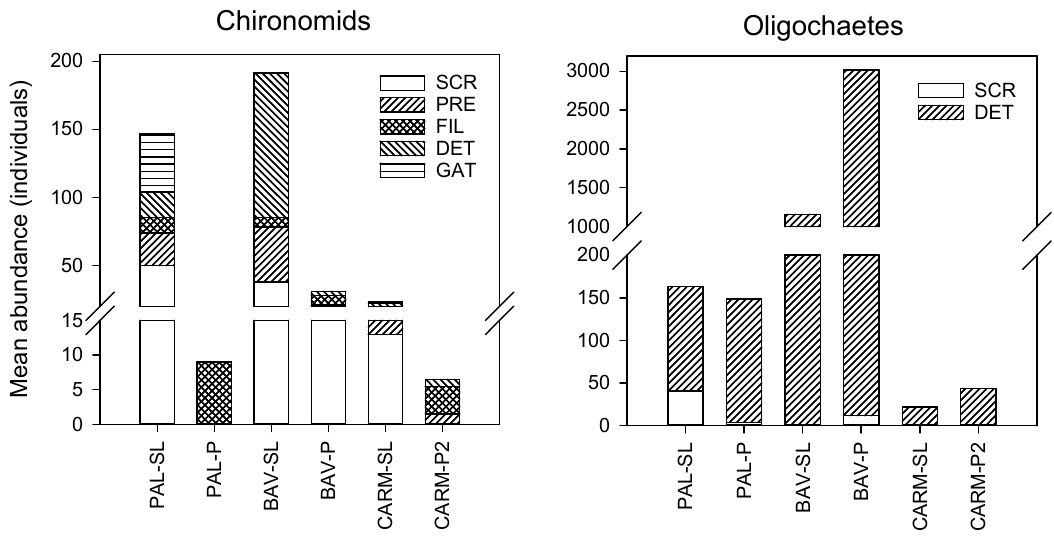
Figure 4. Annual mean densities of chironomids and oligochaetes according to the respective functional feeding groups as defined by USEPA (https://archive.epa.gov/water/archive/web/html/app_b-7.html). SCR: scraper; PRE: predator; FIL: filterer; DET: detritivores; GAT: gatherer.